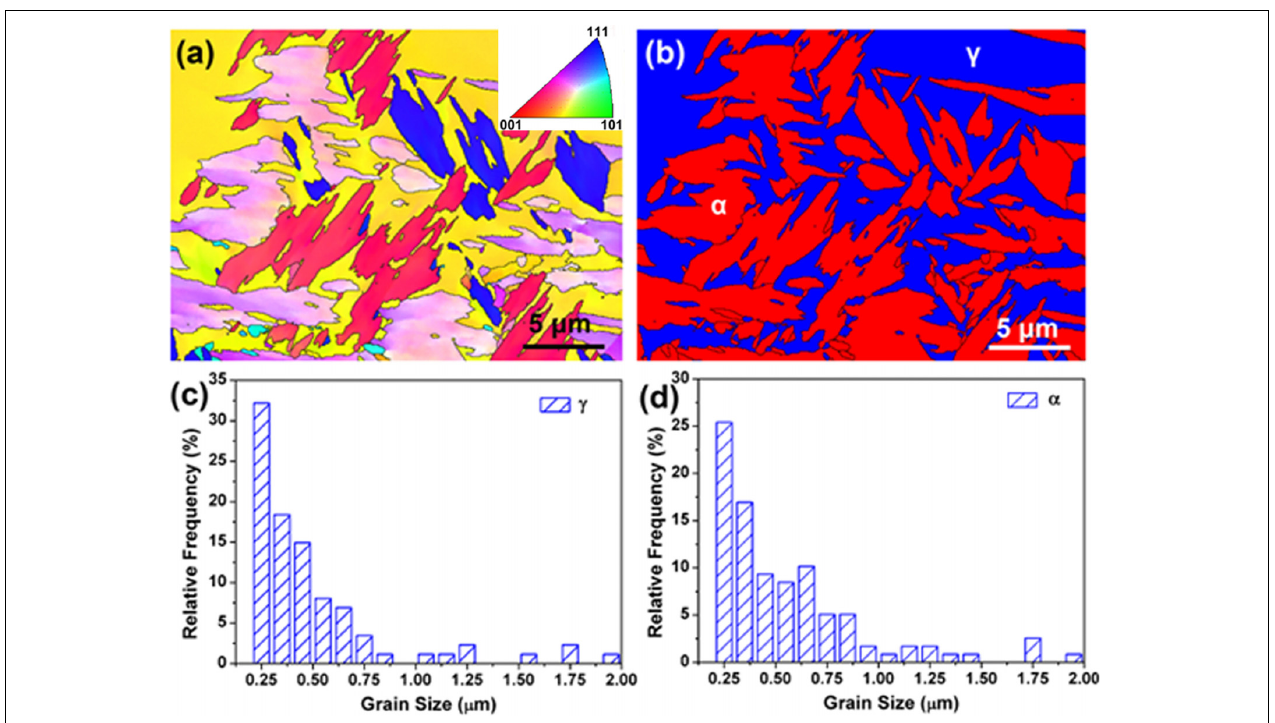
FIGURE 6 | Electron backscatter diffraction orientation map (a) and phase map (b) of the 2205 DSS prepared with the excessive Fe 2 O 3 of 5.0%; grain size relative frequency of γ (c) and α (d) phases.